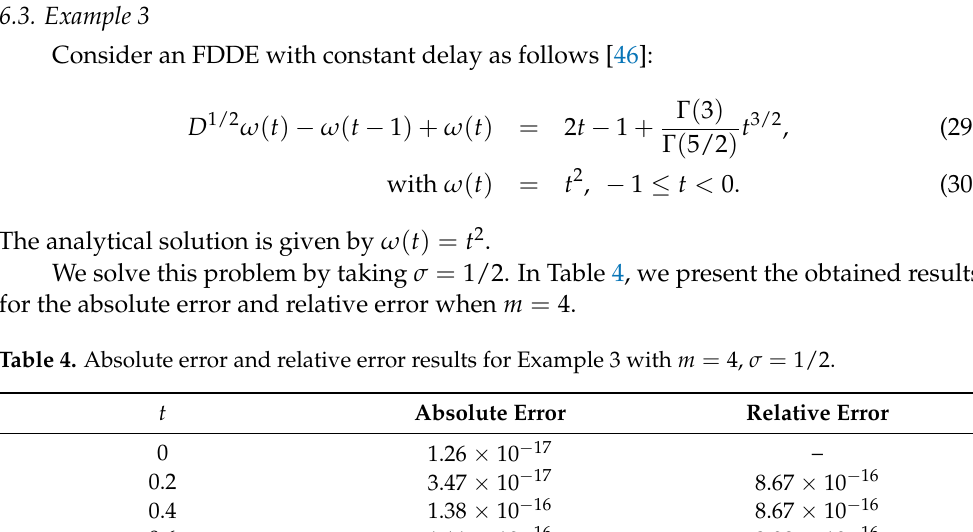
Figure 8. The behaviour of the approximate solutions for Example 2 with different τ values.